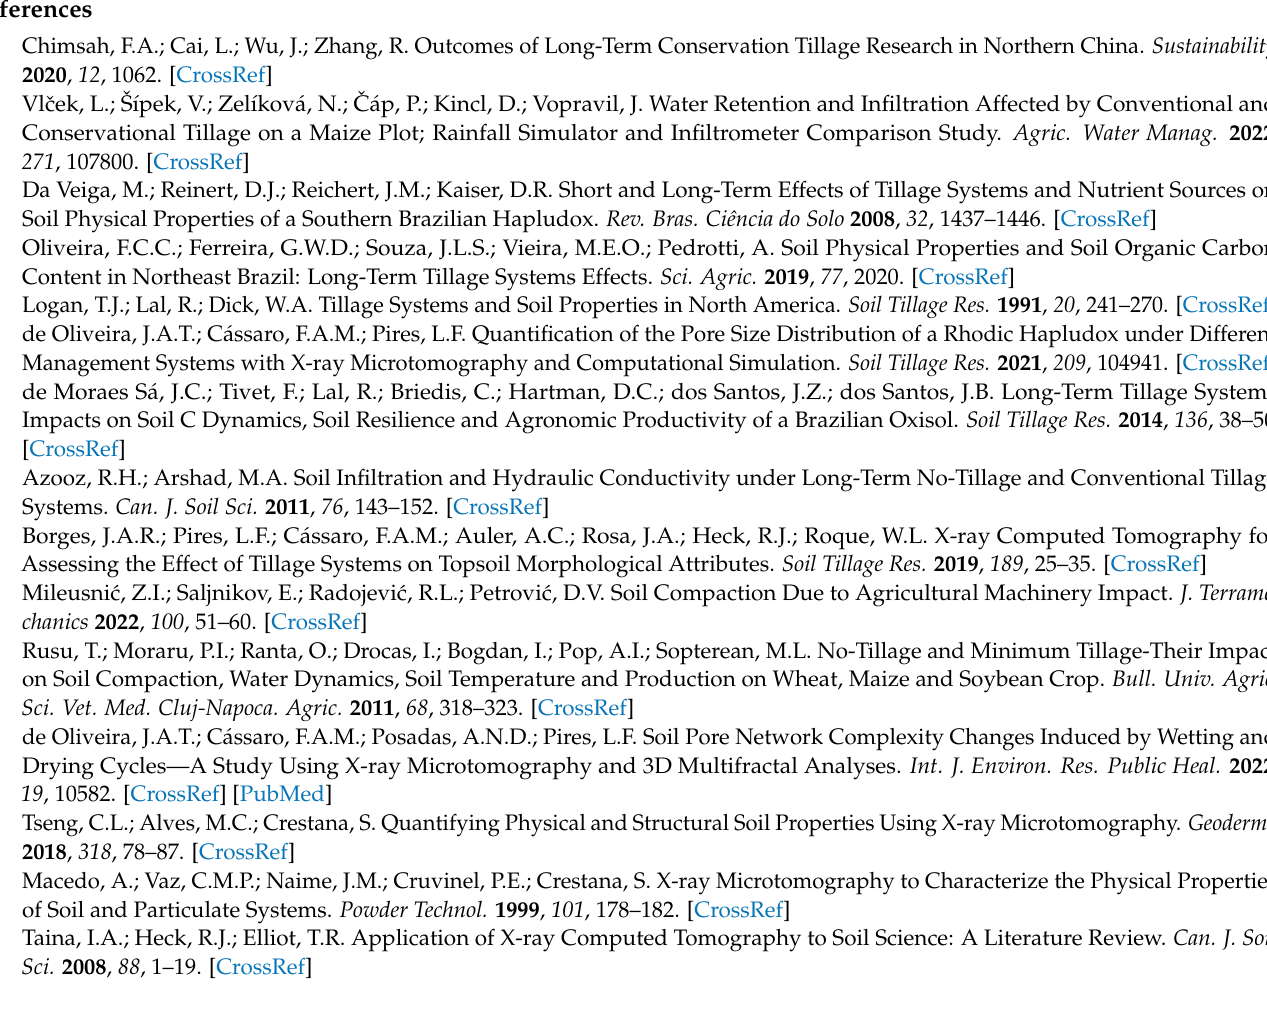
(SF); Figure S2: Schematic representation of the procedures performed in the segmentation of the soil samples. The image shows the result for only one two-dimensional (2D) section of one of the samples under the secondary forest area (SF); Figure S3: Classification of the soil pores based on their shapes; Figure S4: Schematic showing the result of the correlation analysis for the different soil morphological parameters obtained by microtomography analysis. The cool colors indicate positive correlations, while the warm colors indicate negative correlations between the analyzed variables; Table S1: Indices (I: intermediate axis, L: major axis, and S: minor axis) that were used for the shape-based pore